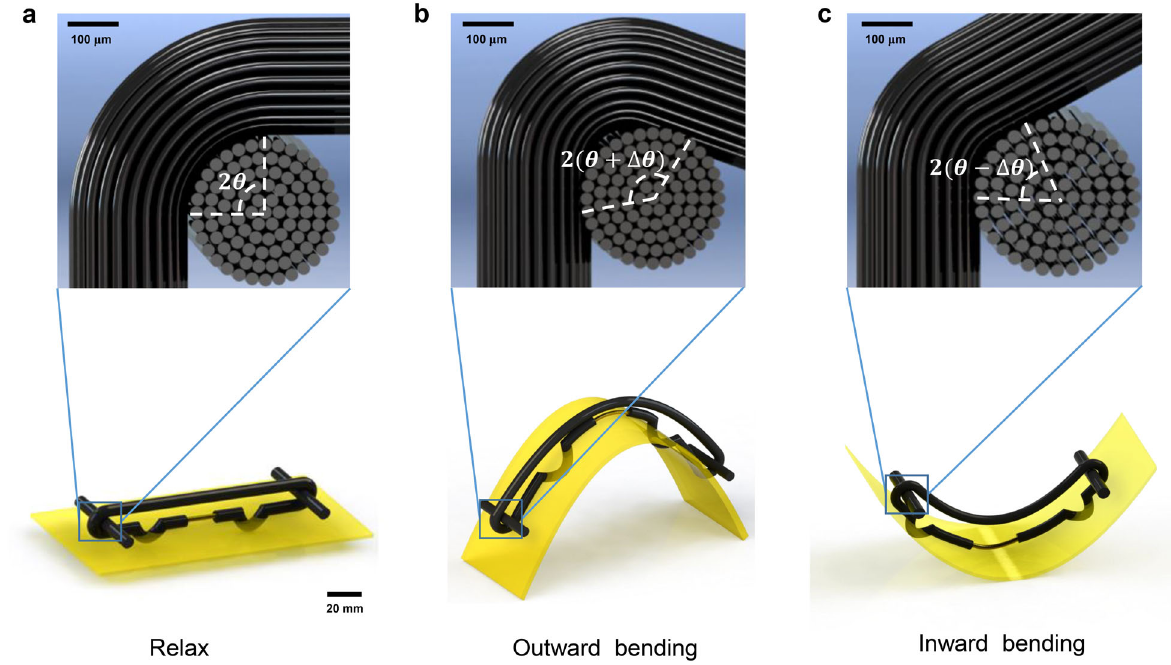
Fig. 1 H-junction structure model for bending sensor. Response in contact area and contact angle of two adjacent fi bers of the junction when the bending sensor at a relaxing, b outward bending, and c inward